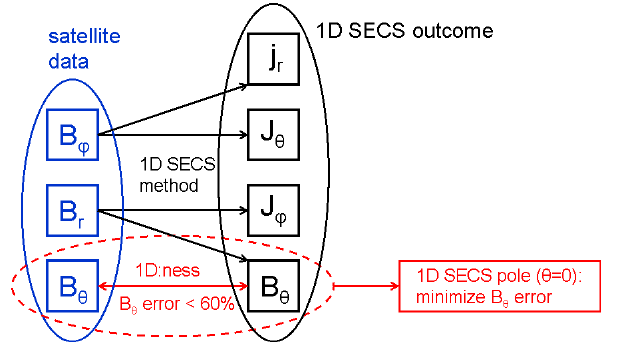
Fig. 2. Determining ionospheric currents from magnetic satellite data using the 1D SECS method: B φ gives j r and J θ , and B r gives J φ . 1D:ness of the current distribution can be estimated from the difference between the 1D SECS B θ , attained by fitting B r , and that measured by the satellite. The optimal location for the 1D SECS pole can be found by minimizing the B θ error (Section 3.2).